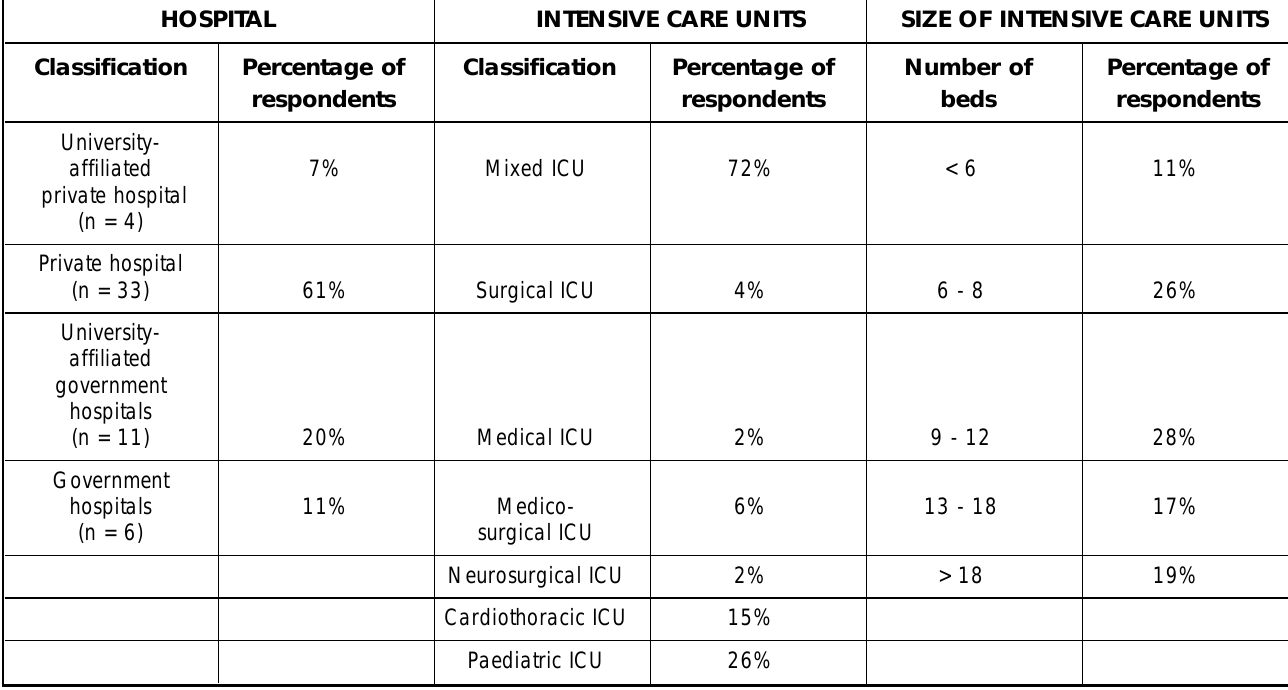
Table 1: Demographics of respondents' hospitals in South African survey.